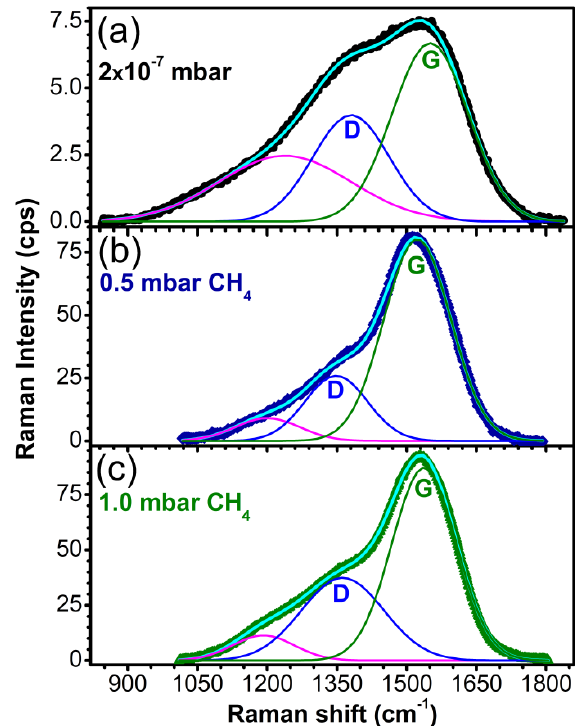
Figure 6. Raman spectra of carbon films synthesized by PLD in ( a ) vacuum; ( b ) 0.5 mbar CH 4 pressure and ( c ) 1 mbar CH 4 pressure on buffered Si (100)